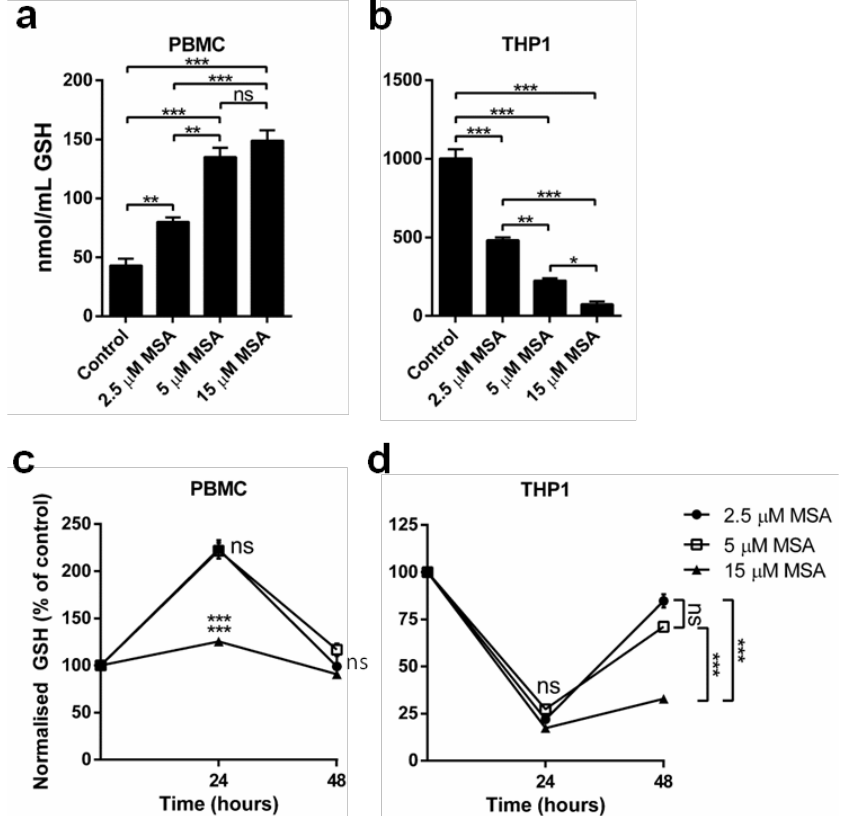
Figure 2. MSA has divergent impact on glutathione (GSH) levels in normal and malignant cells. ( a , b ) GSH quantification in PBMC and THP1 cells demonstrates that MSA significantly reduces GSH levels in THP1 cells and significantly increases GSH levels in PBMCs after 6 h ( n = 5, ± SEM); ( c , d ) Timeline of GSH levels in PBMCs and THP1 cells after MSA treatments demonstrates GSH alterations are maintained for up to 24 h. n = 3, ± SEM, * p < 0.05, ** p < 0.01, *** p < 0.001, ns, not significant.